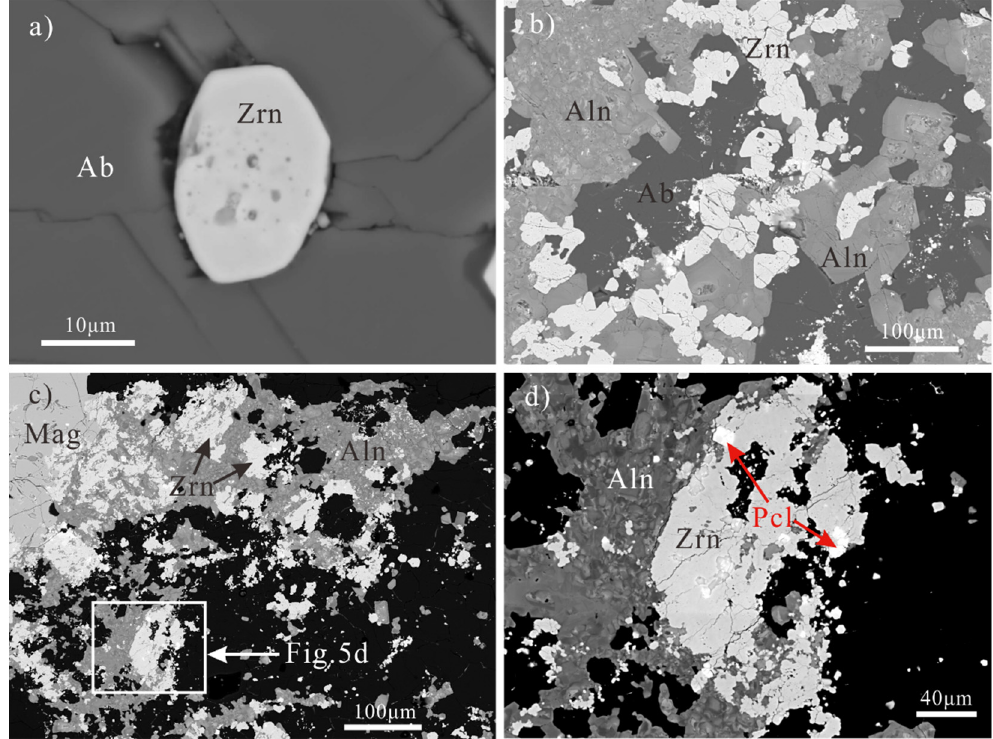
Figure 5. BSE image of zircon with different paragenetic assemblages from nepheline syenite. ( a ) Type-1 zircon grain with slight dissolution pores in the core. ( b ) Type-2 zircons accompanied by subhedral allanite (Aln). ( c ) Type-2 zircon associated with allanite and magnetite (Mag). ( d ) Type-2 pyrochlore (bright white mineral) in type-1 zircon, and this type of zircon is accompanied by subhedral allanite in rock-forming minerals.